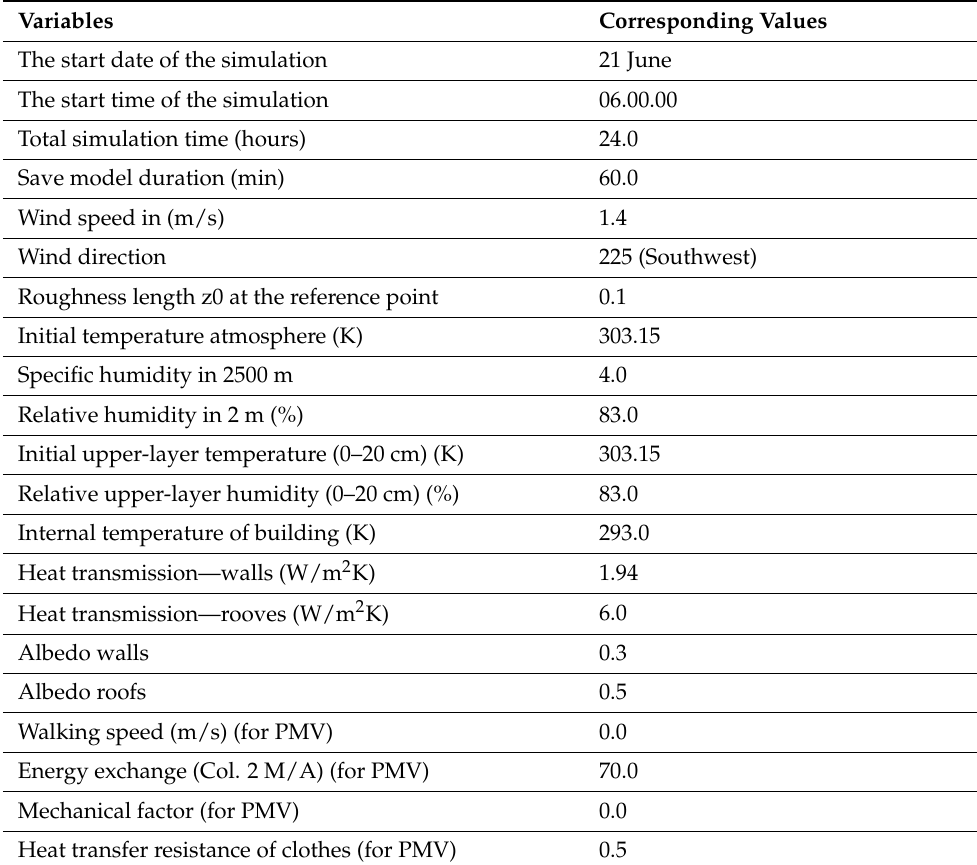
Table 4. Summary of the input parameters considered for the simulations.